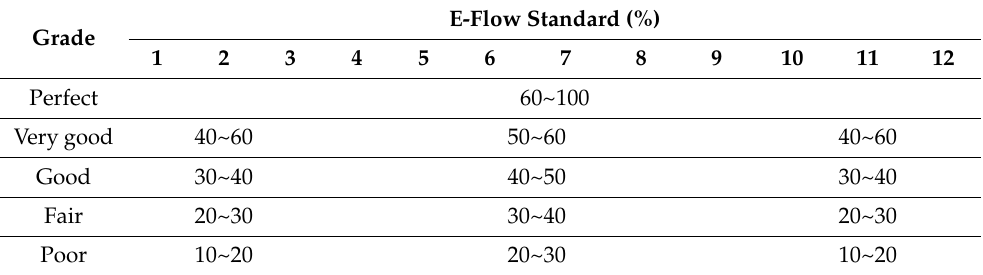
Table 6. Standard evaluation grades for constructing the classical